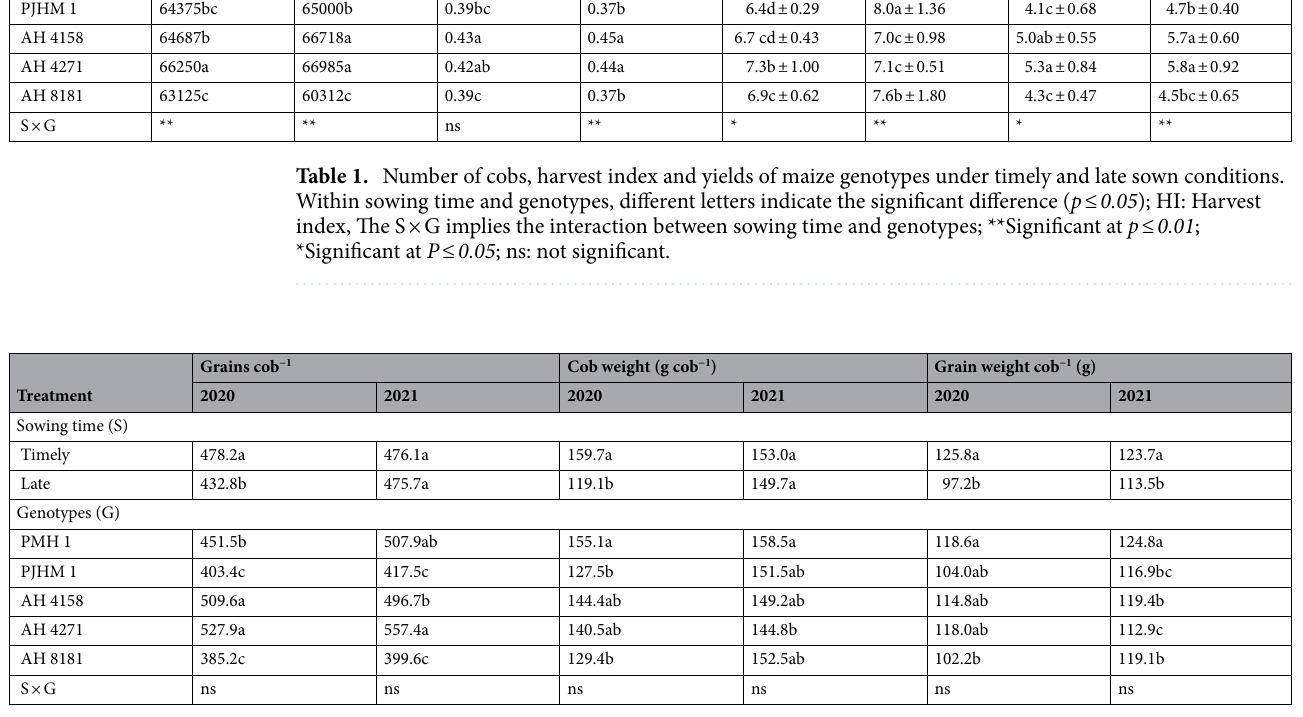
Table 2. Yield attributes of maize genotypes under timely and late sown conditions. Within sowing time and genotypes, different letters indicate the significant difference ( p ≤ 0.05 ); HI- Harvest index; The S × G implies the interaction between sowing time and genotypes; **Significant at p ≤ 0.01 ; *Significant at p ≤ 0.05 ; ns- not significant.